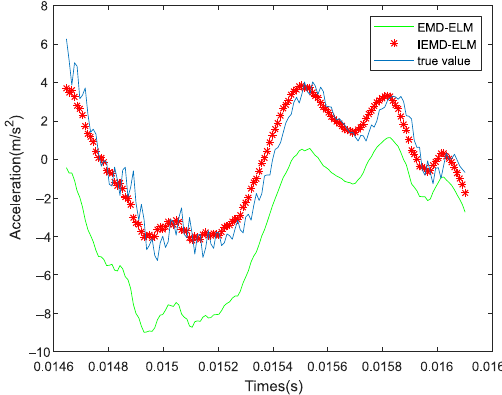
Figure 22. The waveform of prediction signal.